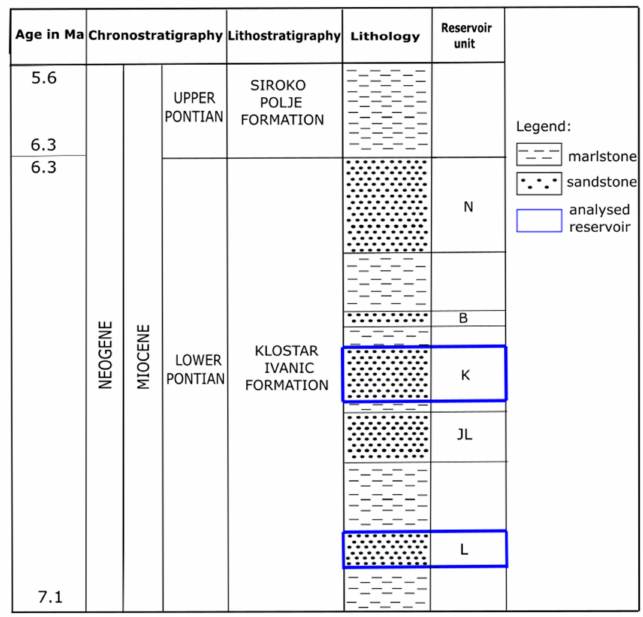
Figure 2. Typical geological column for the western part of the Sava Depression, with (litho + chrono) stratigraphic positions of analysed reservoirs (“L” in “A” Field, “K” in “B”